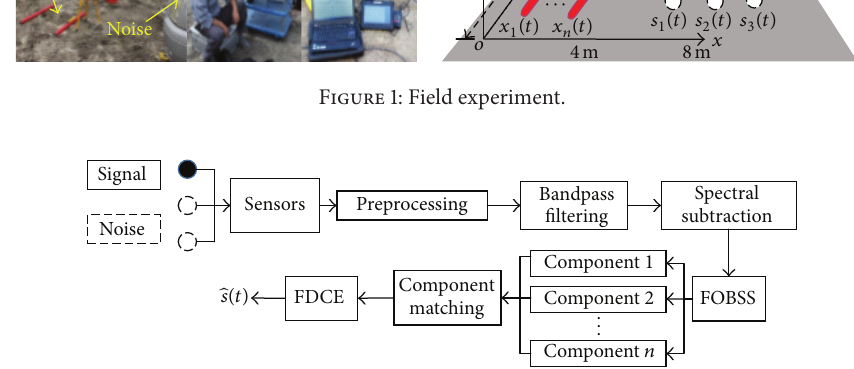
Figure 2: The procedure of signal